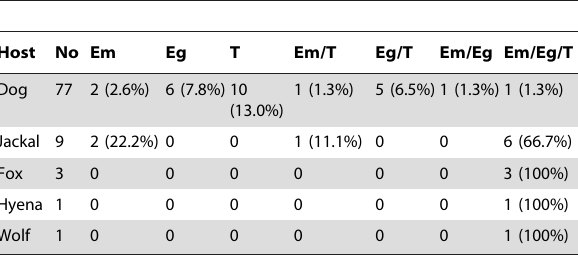
Table 2. Co-infections with E. multilocularis , E. granulosus and